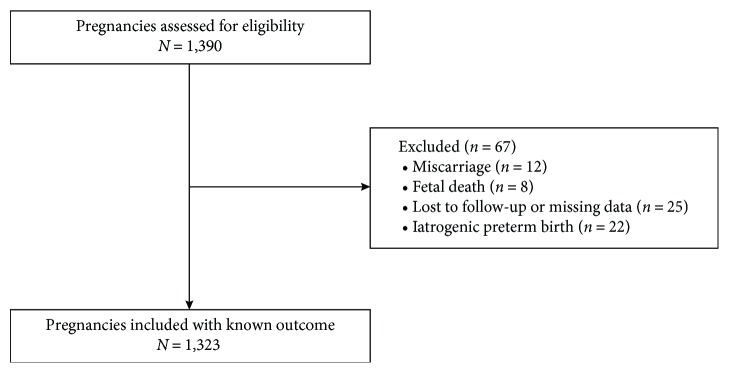
Study population flow diagram.